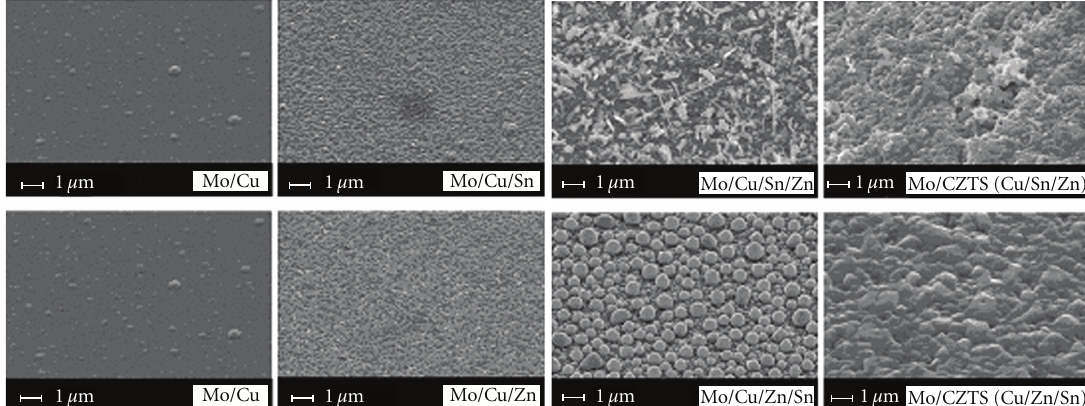
Figure 5: SEM pictures of precursor and CZTS films with di ff erent stacking order of metal layers (taken from